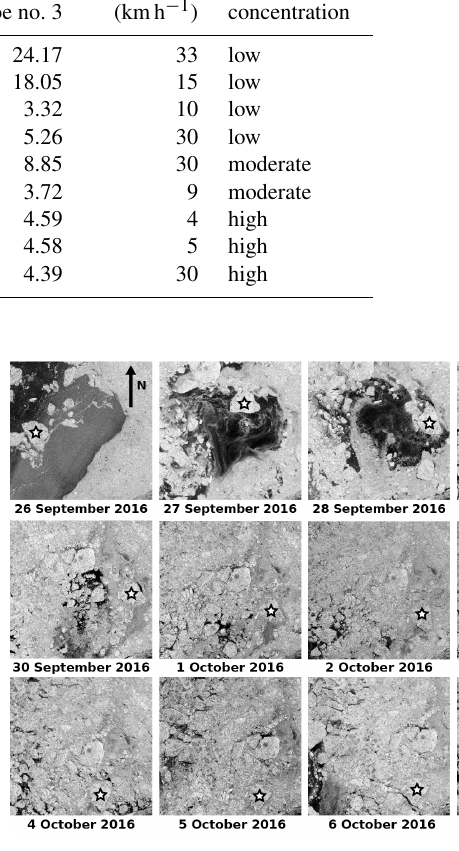
Figure 8. Sequential Sentinel-1A/1B images (dates are shown) showing the advancement of two ice floes. Floe no. 2 is marked by a grey dot (a natural low backscatter area), and floe no. 3 is marked by a star. The ice concentration surrounding each floe is visible and can be qualitatively